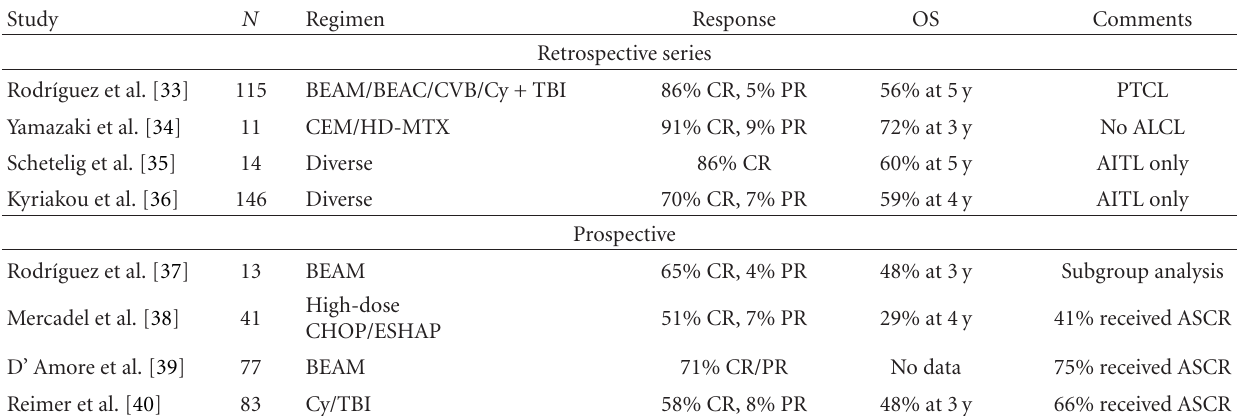
Table 3: Selected results of high-dose chemotherapy and autologous stem cell transplantation in